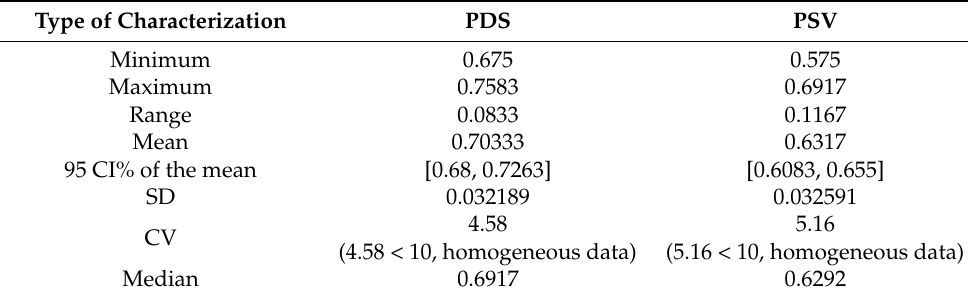
Table 4. Results of the performed descriptive